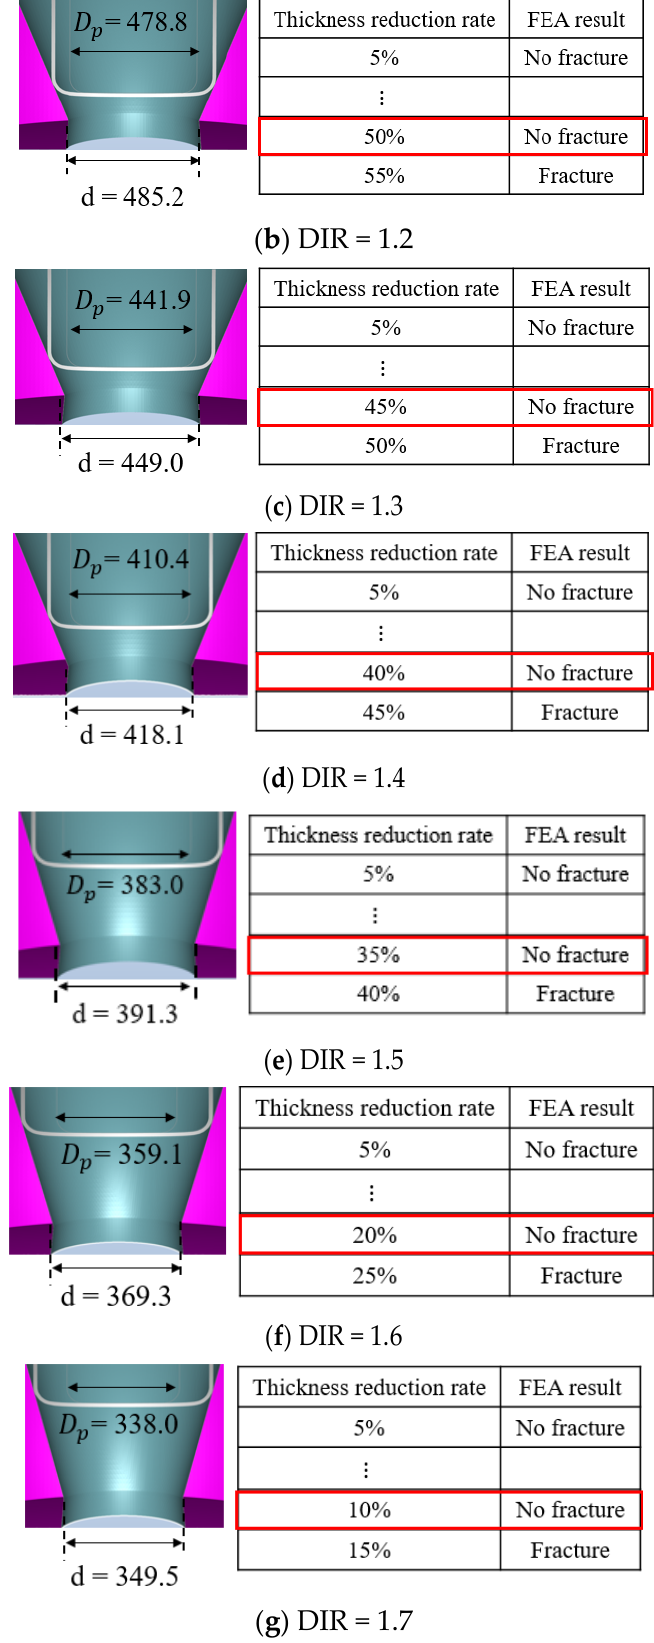
Figure 9. Maximum thickness reduction ratio at each DIR in the 2nd stage.